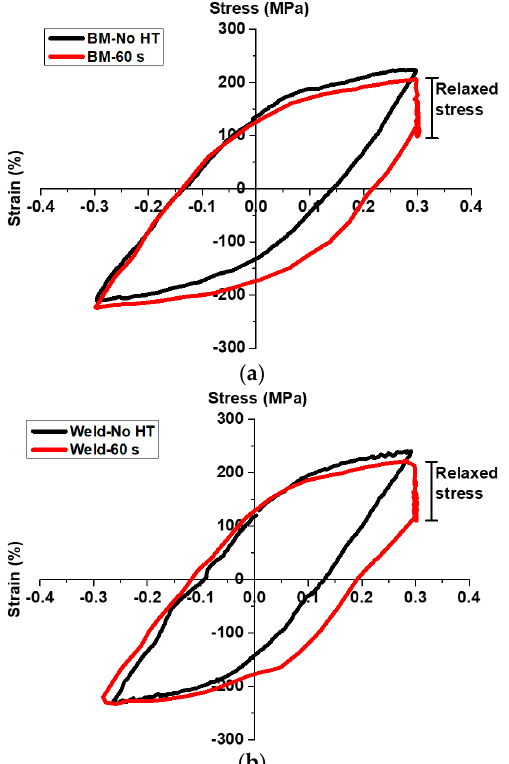
Figure 11. The mid ‐ life cyclic stress–strain hysteresis loops for LCF tests with and without HT of Alloy 800H tested at 0.6% total strain range: ( a ) BM and ( b ) weldments.